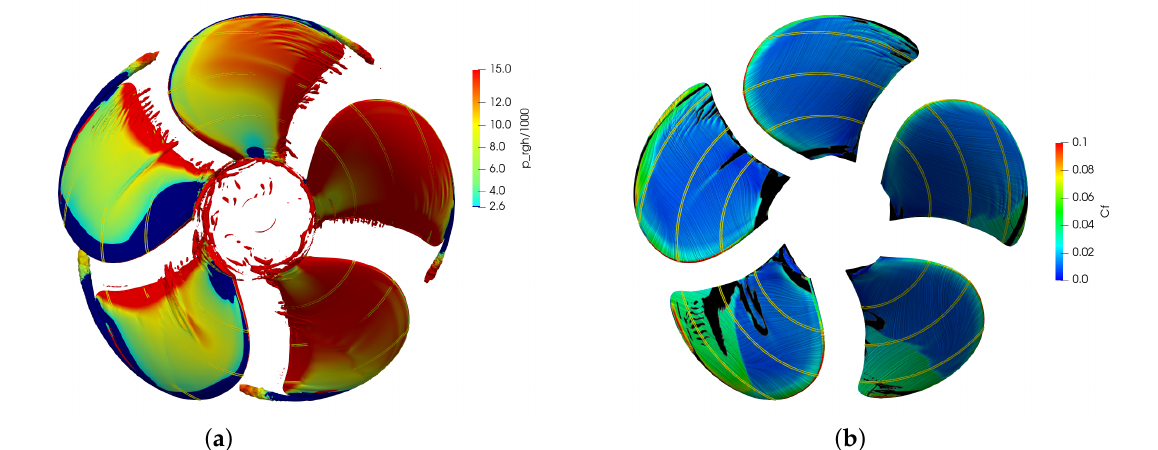
Figure 15. PPTC VP1304 mounted on 12 ◦ inclined shaft, J = 1.019, non-cavitating condition predictions using γ − Re θ model with calculated SepInd . ( a ) Q = 3 × 10 5 colored by pressure; ( b ) SepInd with wall limiting streamlines and contours of C f .